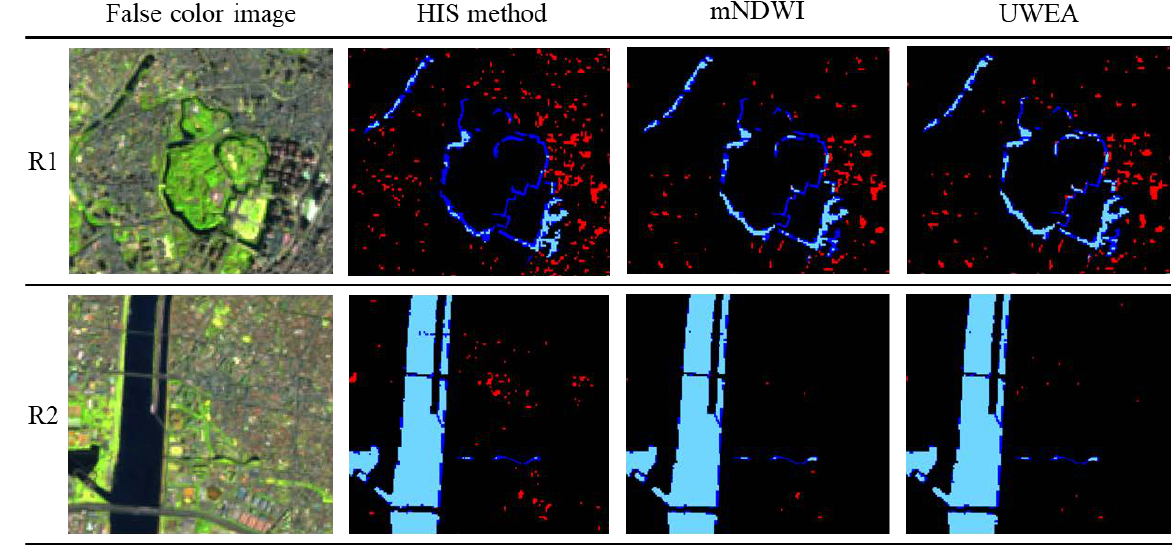
Figure 8. The same as Figure 7 but for Tokyo.